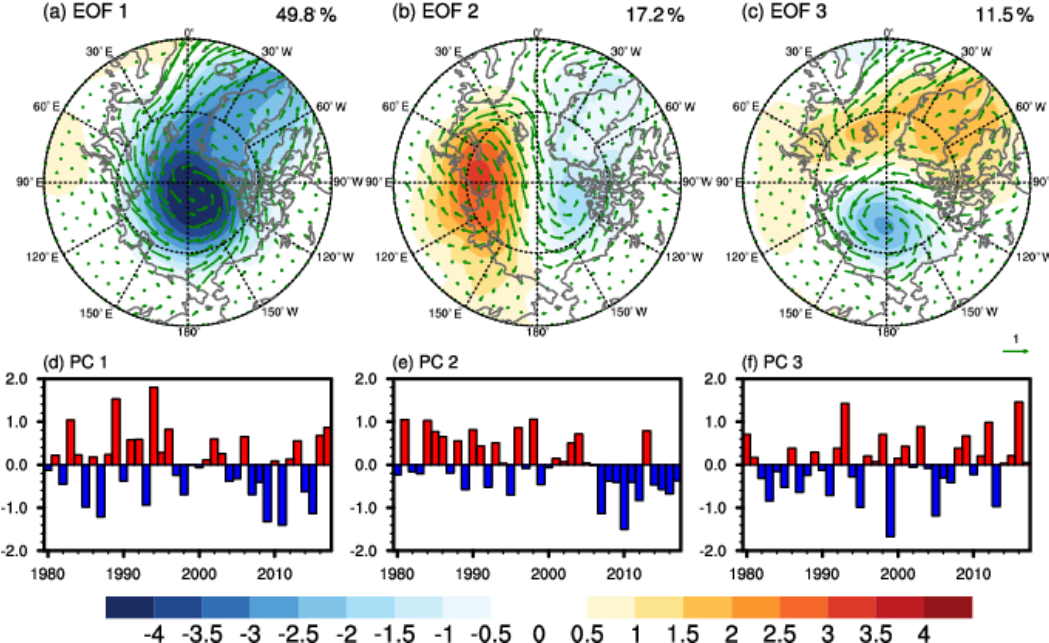
Figure 3. Leading EOFs of JJA-mean SLP anomalies (shaded) for (a) AO, (b) AD, and (c) A3. (d, e, f) are the corresponding time series, respectively. The regression patterns of surface wind onto the corresponding EOF time series are also given in (a, b, c)